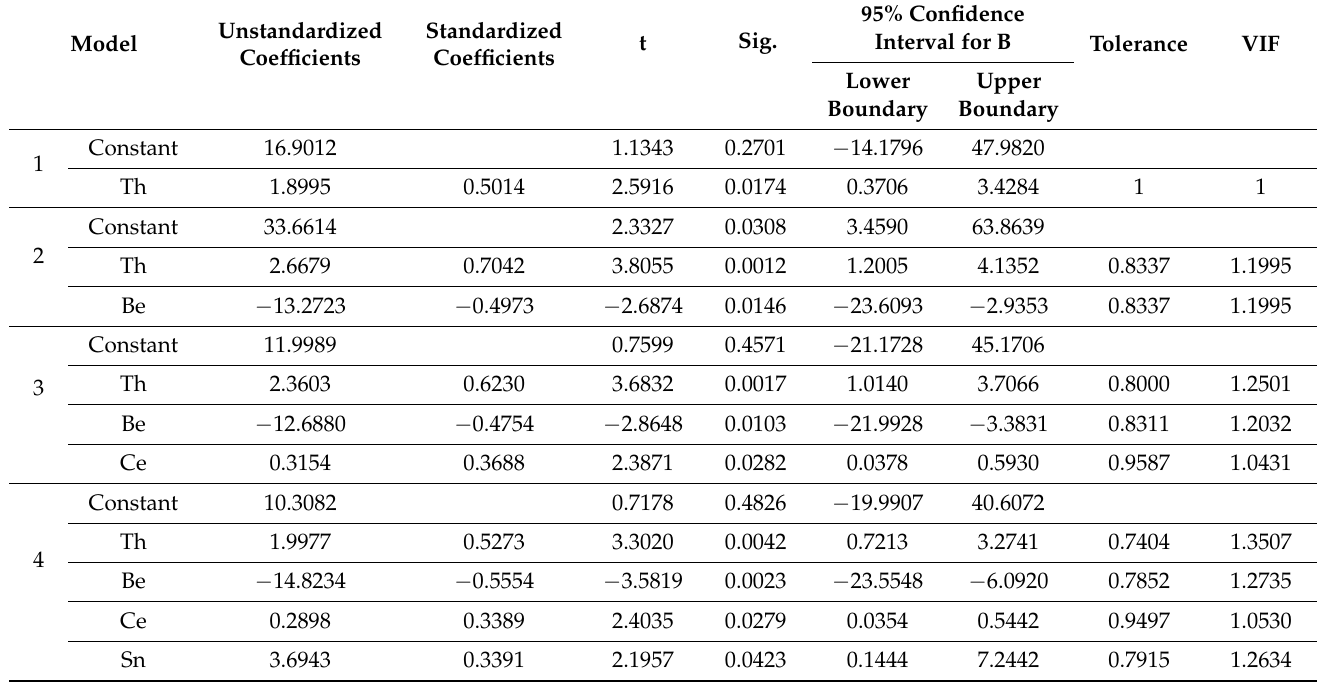
Table 3. Liner regressive